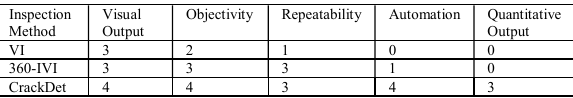
Table 1: comparison between the inspection methods